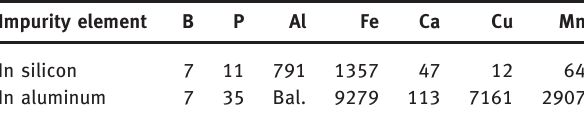
Table 1: Impurities contents in the raw materials (ppmw). Impurity element